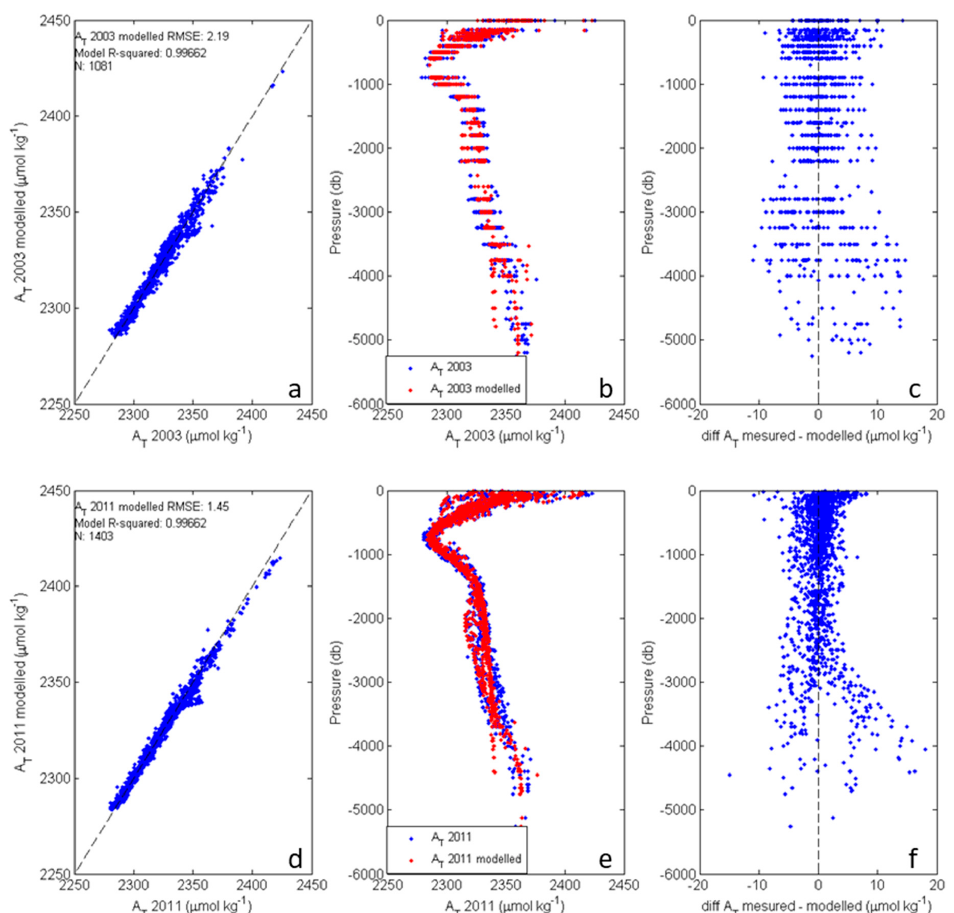
Figure 5. A T model results considering the A10 section of 2003 ( a – c ) and 2011 ( d – f ); measured vs. modeled A T ( a , d ), including the RMSE of the model equation, measured vs. modeled r 2 , and number of measurements (N); measured (blue dots) and modeled (red dots) vertical profiles ( b , e ); vertical profile of the difference between measured and modeled A T ( c , f ). The A T and A T -differences units are μ mol kg − 1 .